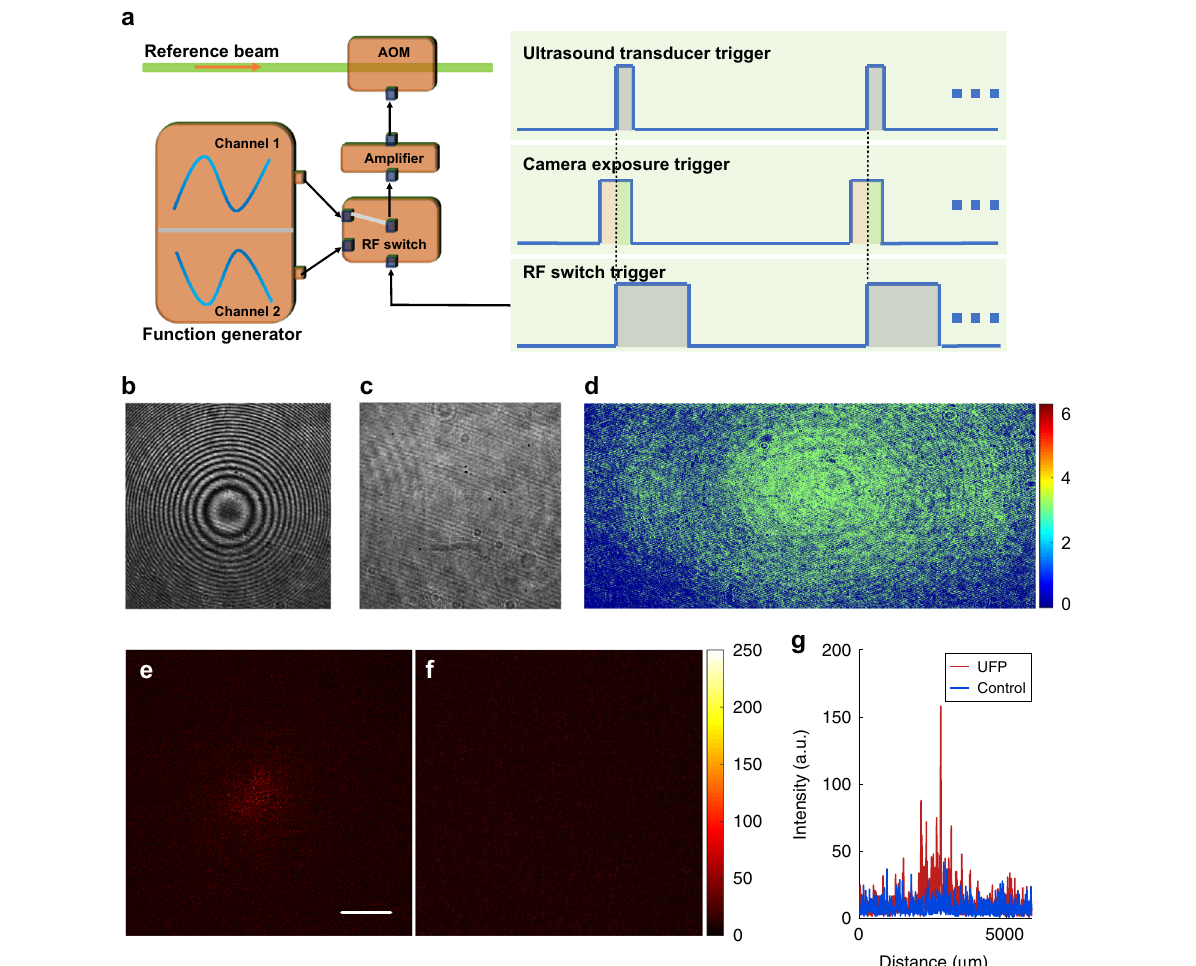
Fig. 6 Single-shot UFP optical focusing into scattering media. a Time sequence for the single-shot realization of UFP optical focusing. b In general interferometers, if a light beam with a spherical wavefront interferes with a plane reference beam, a typical interferogram with many circular fringes will be seen. c In our system, because the phases of the reference beam were reversed during the fi rst and the second halves of the camera exposure period, the interference terms canceled out completely, resulting in no interference fringes. d Phase map generated from the recorded single hologram. e Time-reversed focus from single-shot UFP optical focusing. f A control experiment without launching the ultrasound, yielding no focus. g Line pro fi les of the central rows in e and f . Scale bar: 1